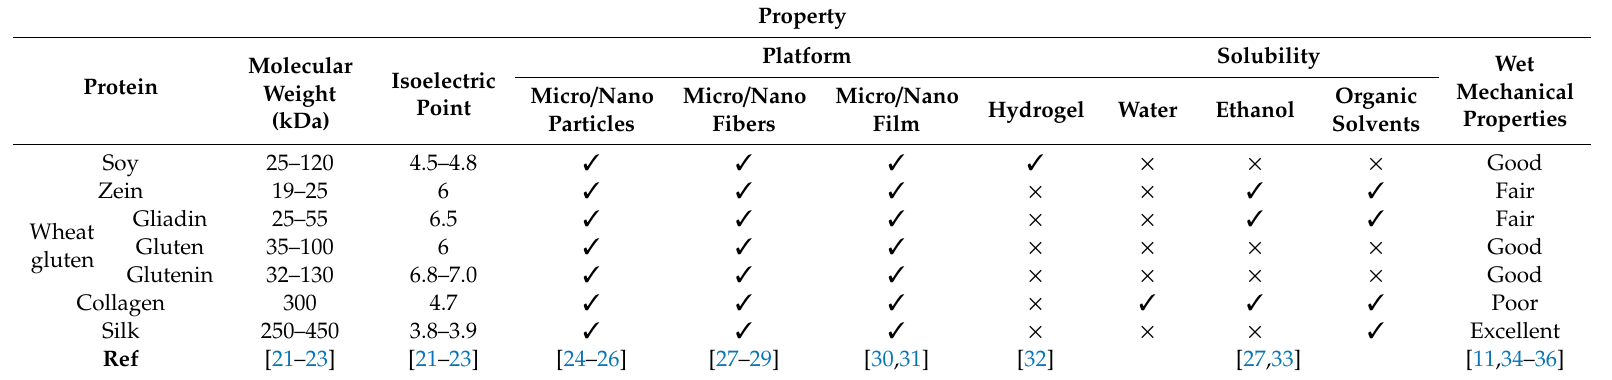
Table 1. A Comparison between properties of plant proteins and animal proteins. Data from Reference